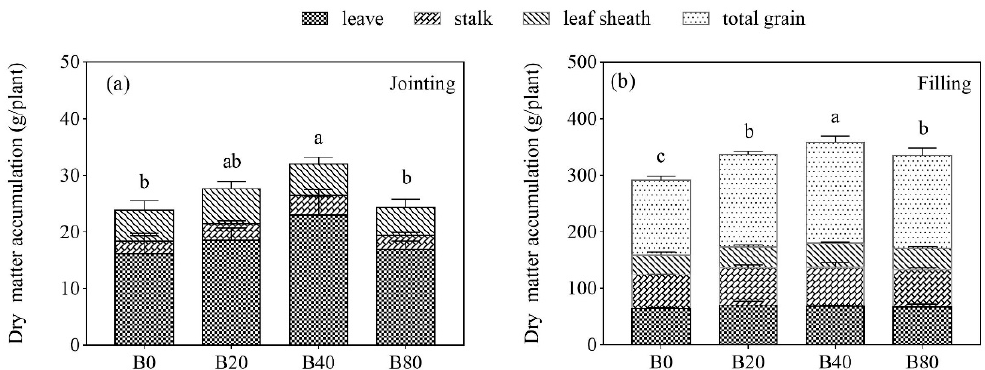
Figure 6. Effects of biochar on dry matter accumulation of maize. Note: Different letters indicate significant differences (one-way ANOVA, p < 0.05, Duncan analysis).